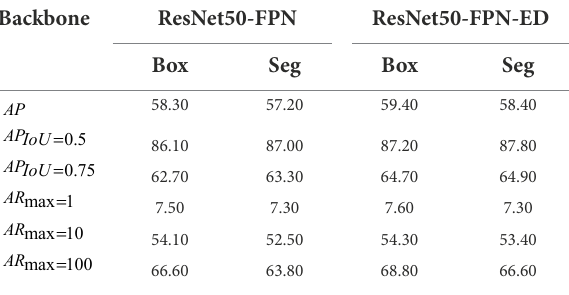
TABLE 9 Comparison of test results with different backbones based on dataset